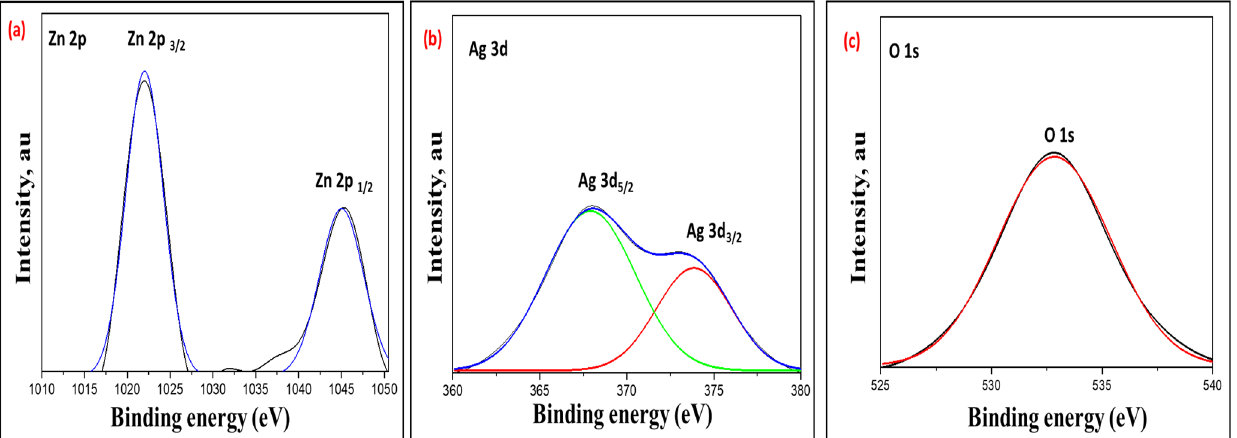
Figure 6. High-resolution XPS spectra of CA@Ag (0.1) /ZnO hybrid material, the Zn 2p ( a ), Ag 3d ( b ), and O1s ( c ). and O1s ( c